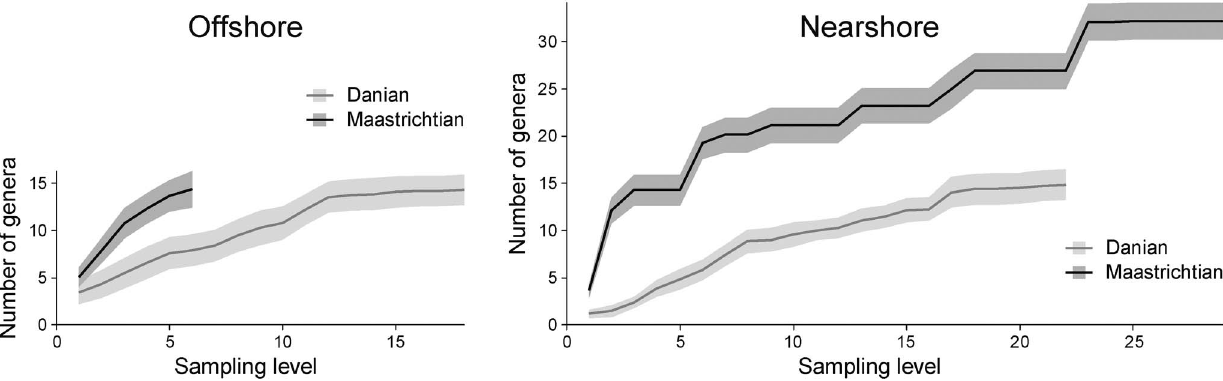
Figure 2. Comparing Cretaceous (Maastrichtian) and Palaeogene (Danian) accumulation curves for the estimated number of molluscan genera. Sampling level refers to consecutively numbered fossiliferous samples, arranged from stratigraphically oldest to youngest, and shows the cumulative number of genera at the respective level (see text for details on pooling and standardising of samples). Grey areas indicate the standard deviations around the means. In both offshore and nearshore habitats total diversity in the Danian is consistently lower than total Maastrichtian diversity at any given sampling level.